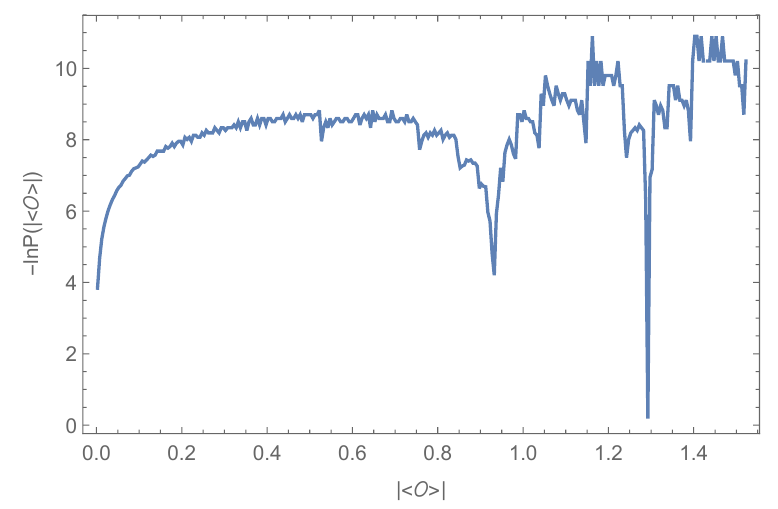
Figure 5 . Probability distribution of the superconducting order parameter in the whole evolution process for Q = 2 and q = 6 . 5 . Typically, the order parameter is equally discretized with the interval δ = 0 . 005